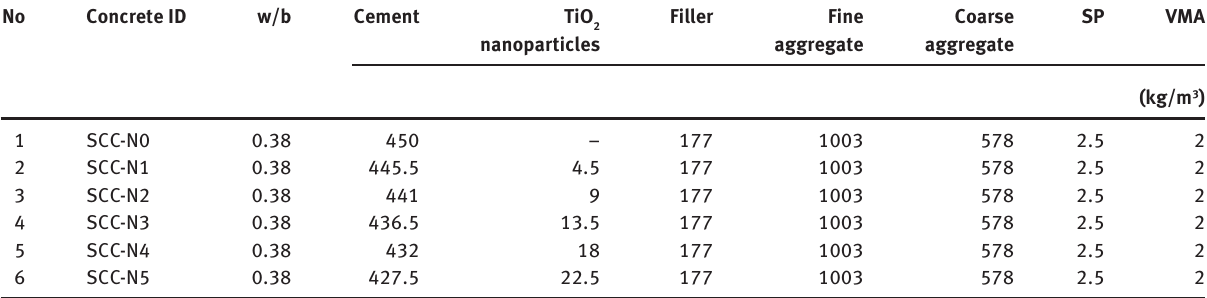
Table 3 Mix proportions of the concrete